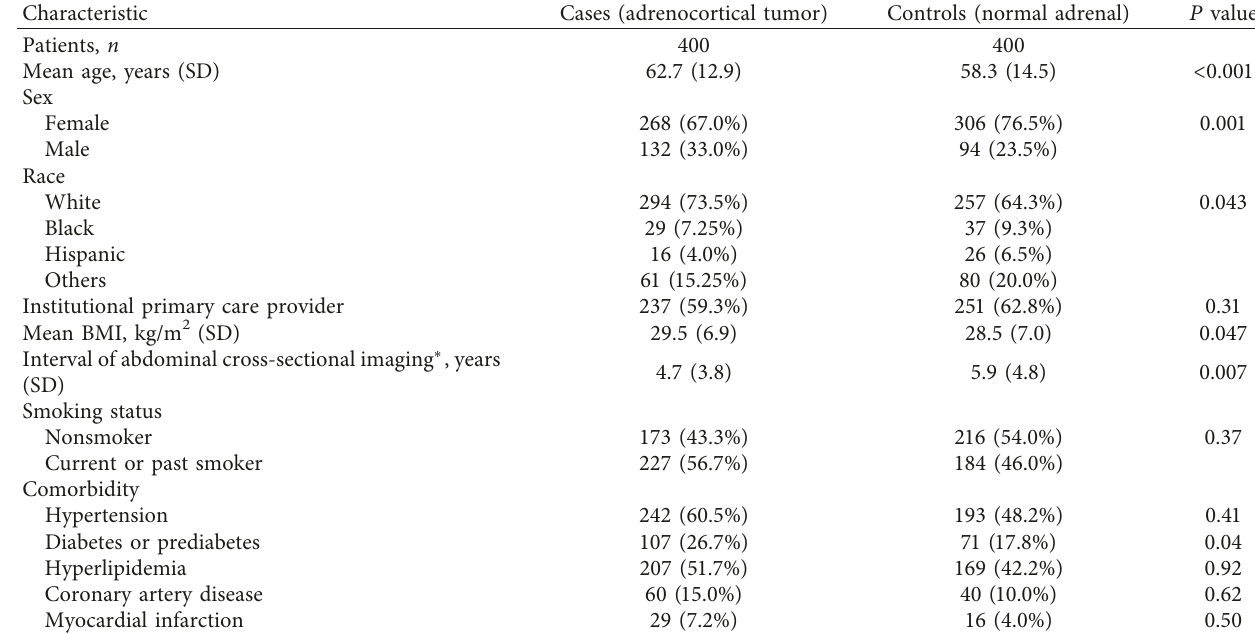
Table 3: Baseline demographic and clinical characteristics of cases and